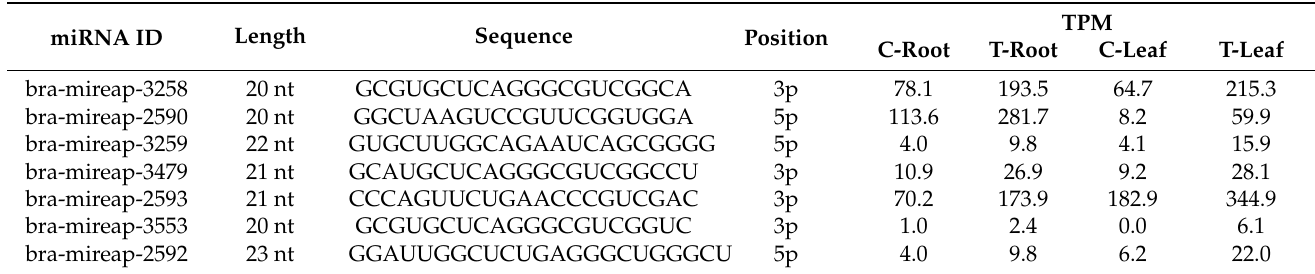
Table 5. Novel miRNAs related to Cd resistance.